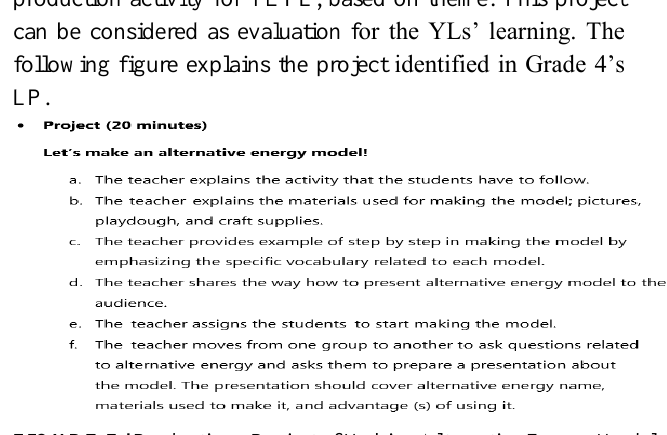
FIGURE 7 | Production - Project of Making Alternative Energy Model Figure 7 elucidates the PST 4 detailed explanation by providing steps to avoid students’